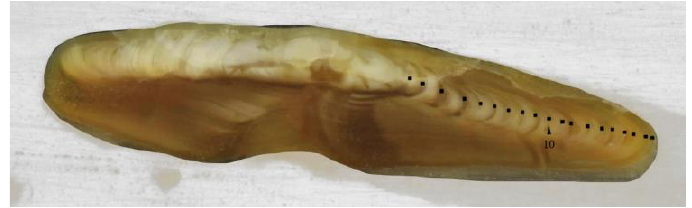
Figure 1. Sagittal otolith section of a M. caml aged 19 years old.